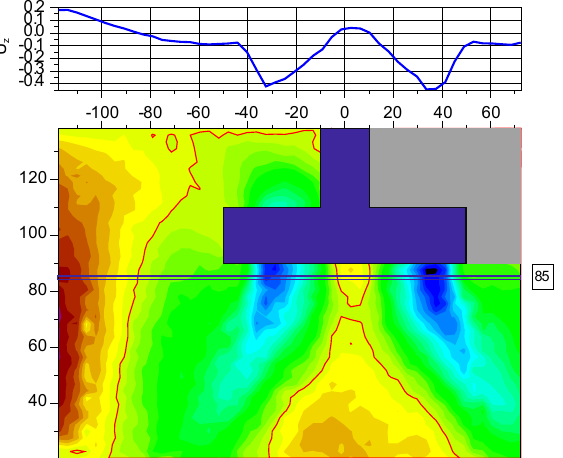
Figure 4. Map and profile of axial velocity at a height of h = 85 mm above the bottom for h w = 140 mm and N = 90 min − 1 (PBT45 impeller).